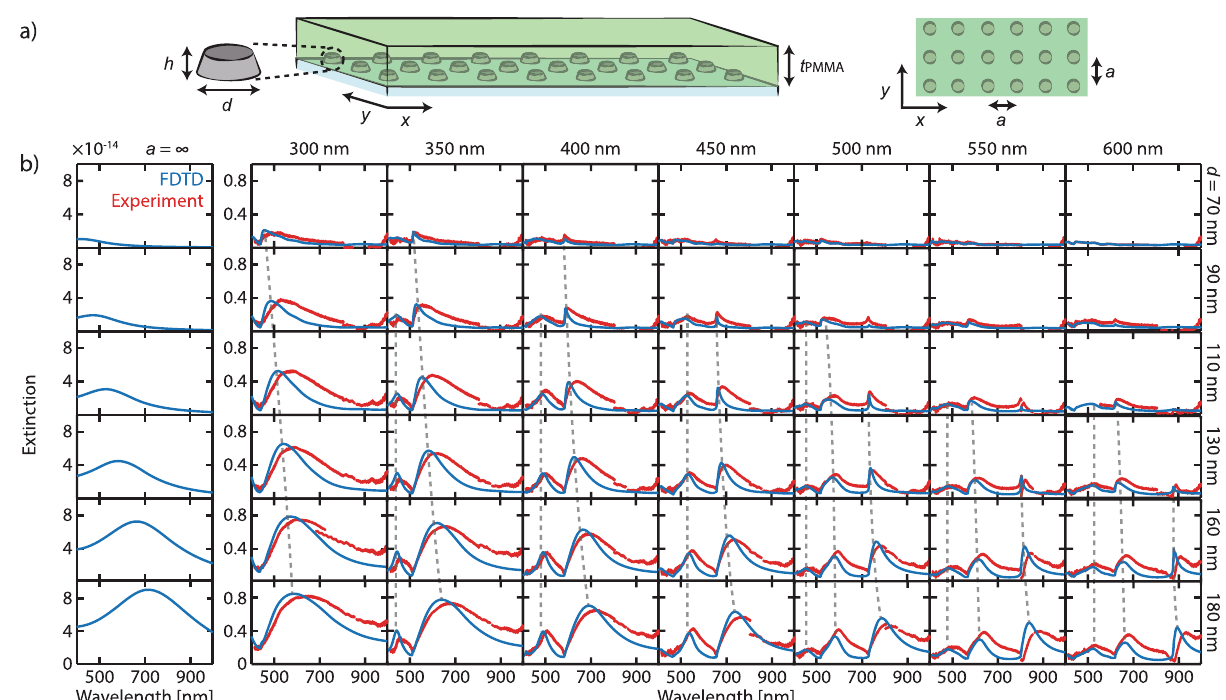
Fig. 1 | Optical extinction spectra of Pd nanoparticles in a periodic array. a Schematic of the sample. b A collage of experimental (red) and simulated (blue) extinction spectra at normal-incidence from Pd nanodisk square arrays of fi xed height, h , of 45nm and PMMA layer thickness, t PMMA , of 200nm. The pitch of the array, a , increases from left to right from 300 to 600nm. The nanodisk diameter increases from top to bottom from 70 to 180nm. For comparison, the leftmost